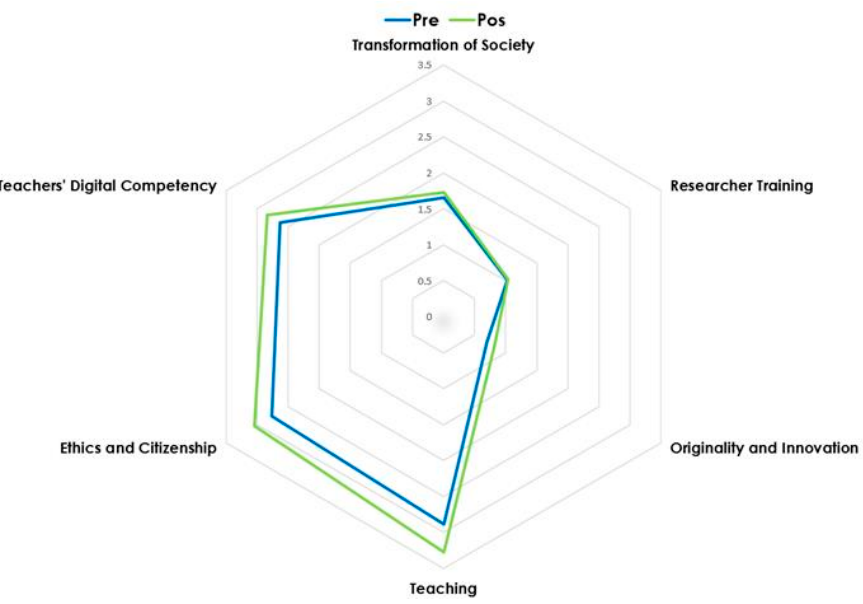
Figure 9. Comparison of professors’ performance by competency after one year.